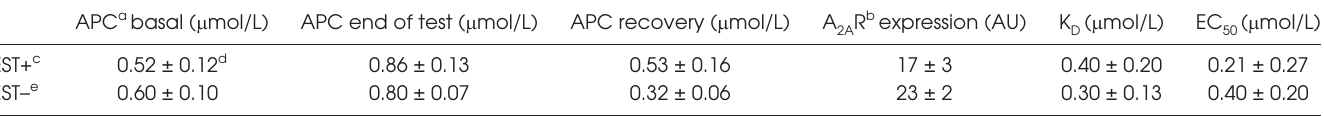
Table 2. Biological variables of patients with positive and negative exercise stress test.